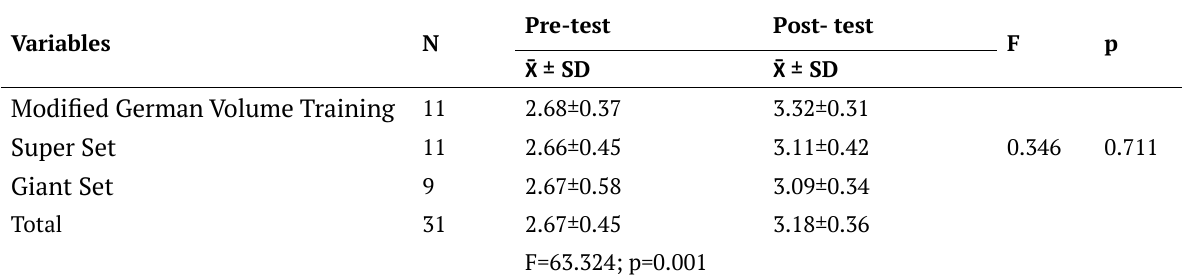
Table 4. Pre-test and post-test comparison of latissimus dorsi thickness values of the groups Variables